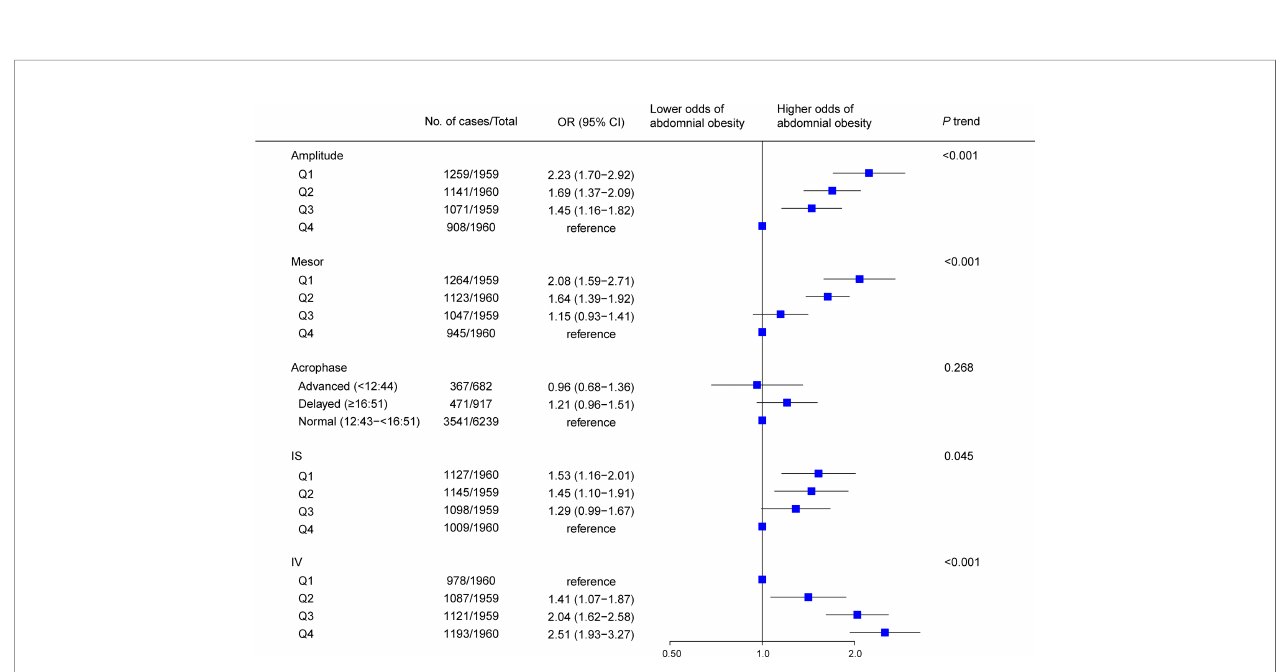
FIGURE 3 | Association between rest-activity rhythm parameters and abdominal obesity among US adults (n=7838). Odds ratio (datapoints) and 95% con fi dence interval (error bars) are presented. CI, con fi dence interval; IS, interdaily stability; IV, intradaily variability; OR, odds ratio.